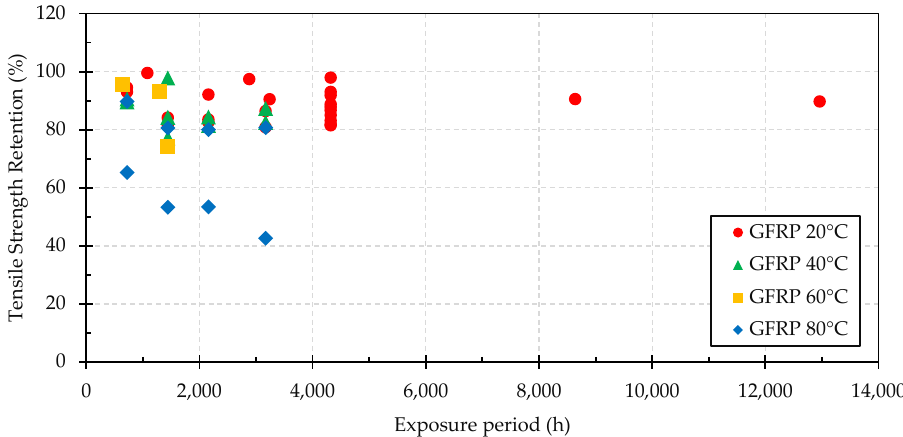
Figure 3. GFRP bars immersed in saline solution (adapted from Duo et al. 2021 [14]).